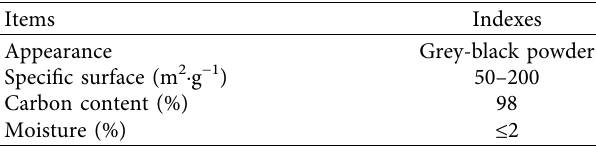
Figure 2: Graphene oxide. Table 3: Performance indexes of